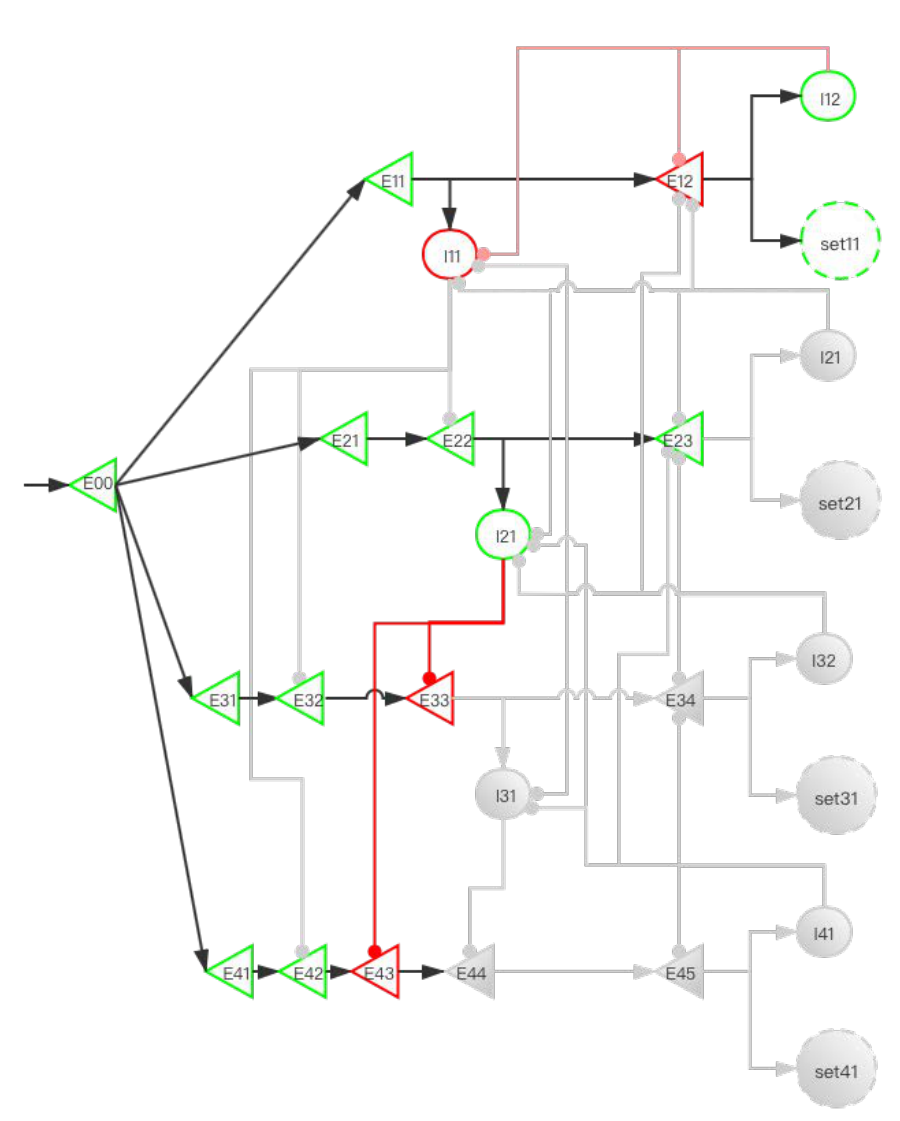
Figure 8. The activity of neurons in the time period from the activation of set11 by the first signal to the activation of E23 by the second signal (before set21 is activated). After the signal enters E12, set11 and I12 are activated, and set11 performs information storage. I12 inhibits I11, which eliminates the influence of I11 on other pyramidal neurons when the second signal enters. The suppression of E12 by I12 increases the difficulty of replacing set11 when other SETs are not activated. After the second signal enters, the E11 branch has been locked, but the latter branch is still open and can be used for storage. E22 activates I21, and I21 is used to inhibit E33 and